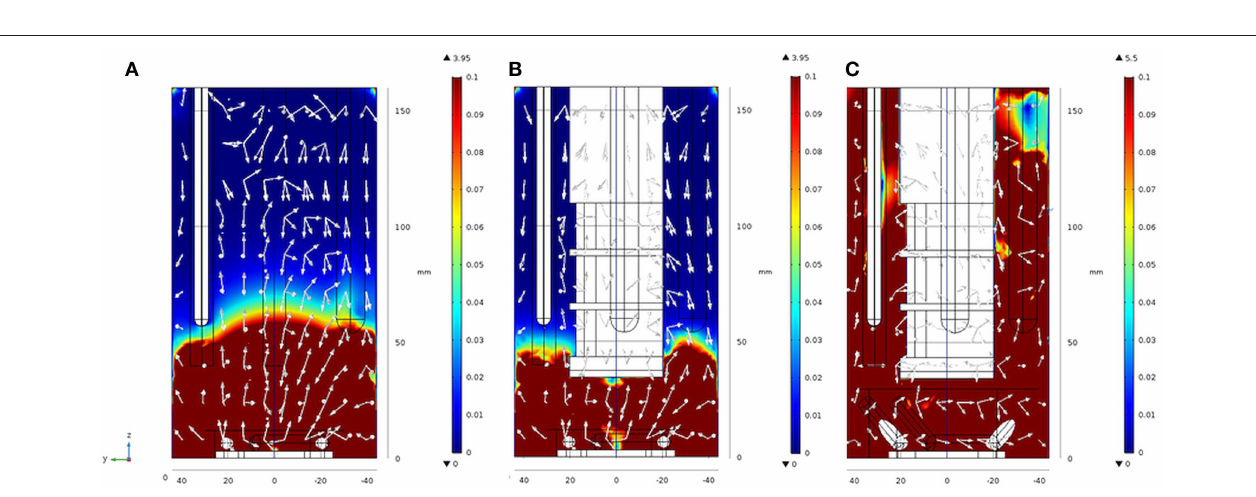
FIGURE 5 | Results from finite element modeling: velocity magnitude fields obtained for t = 0.6s, 1,000 rpm in setups 2 (A) , 3 (B) , and 4 (C) in y-z cut planes of the geometry. White arrows are normalized and only serve to indicate the main direction of the velocity magnitude. 3D views of the same Figures are found in Figure SI 4A–C . For further details see also Figure SI 4